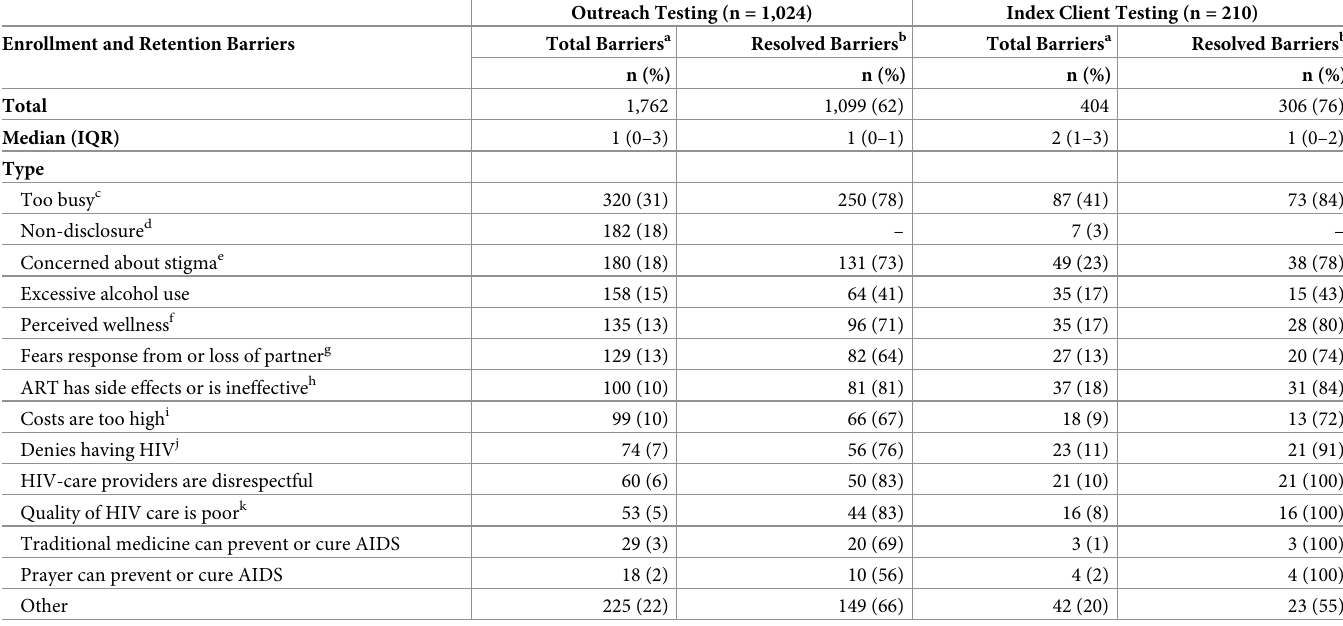
Table 3. Number and type of total identified and resolved barriers to enrollment and retention in HIV care among CommLink clients, by route of participation, Eswatini, June 2015 –September